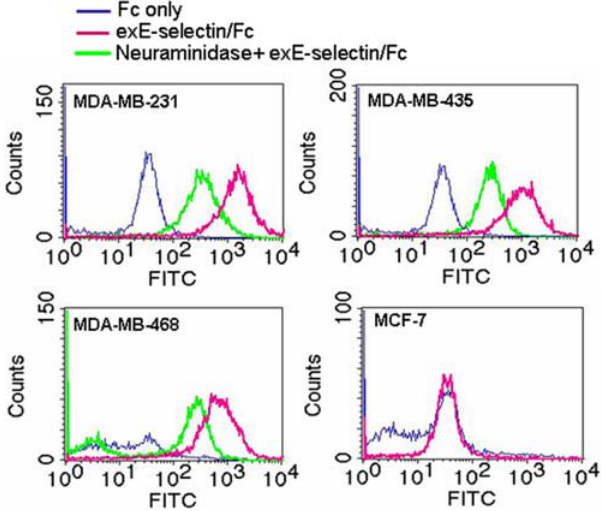
Figure 2. Binding of soluble exE-selectin/Fc recombinant to breast cancer cells via sLe x moieties on the tumor cell surface. Trypsin-elicited breast cancer cells were surface labeled with soluble exE-selectin/Fc or Fc-only as detailed in the Methods. The bound Fc recombinants were detected by Alexa Fluor 488-conjugated goat anti- rabbit Fc and measured by FACS. In separated experiments, tumor cells were treated with neuraminidase to remove surface sLe x moieties before exE-selectin/Fc binding.